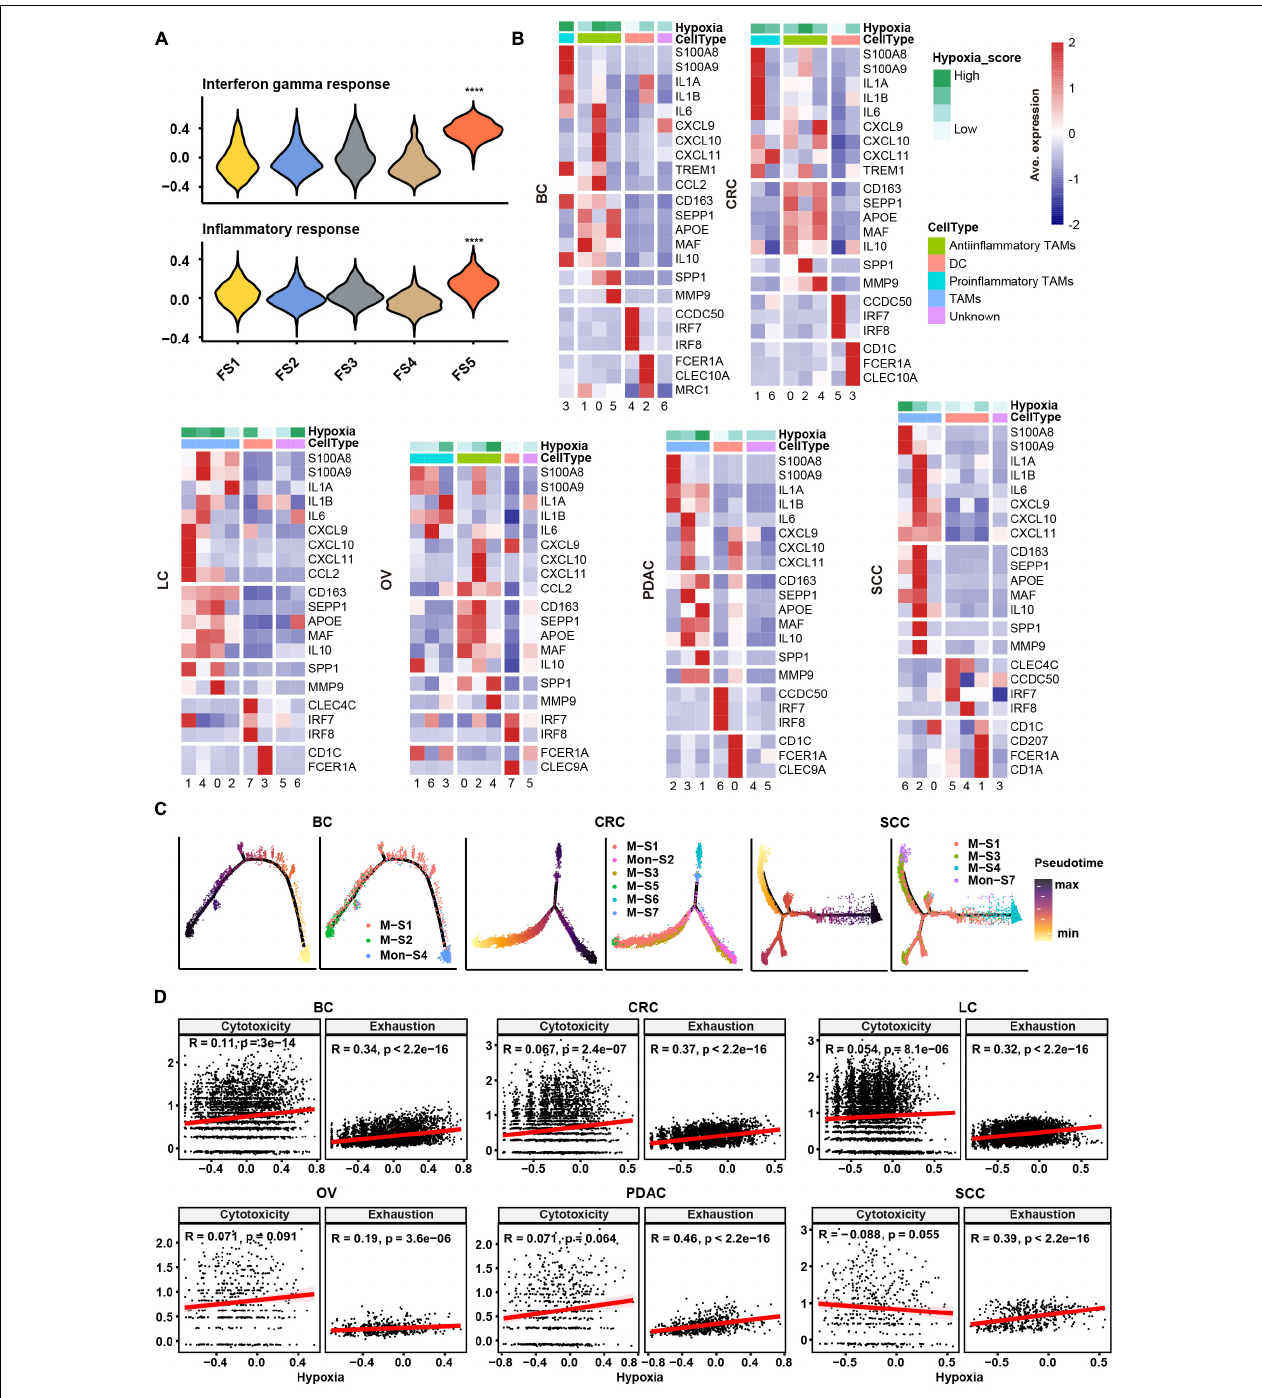
FIGURE 2 | Subtype classification and characteristics of non-malignant cells across cancer types. (A) Hallmark gene set scores for interferon gamma response (top) and inflammatory response (bottom), computed for all fibroblast clusters in BC. FS1, FS2, FS3, FS4, and FS5 are subclusters 0, 1, 2, 3, and 4 in stromal cells, see Materials and Methods and Supplementary Figure 2A . **** p ≤ 0.0001, two-sided Wilcoxon rank sum test. (B) Heatmap of Z -score-normalized log 2 (count+ 1) expression of canonical marker genes for myeloid cells. The color of the square on the top map indicates the average hypoxia score for each myeloid cell cluster (low to high, light green to green). (C) The branched trajectory of myeloid cell state transition in cancer (BC), colorectal cancer (CRC), and squamous skin cancer (SCC) inferred by Monocle 2. Each dot corresponds to one single cell, colored according to its cluster label. Subclusters 0, 1, 2, 3, and 4 of macrophages/monocytes were labeled M-S1/Mon-S1, M-S2/Mon-S2, M-S3/Mon-S3, M-S4/Mon-S4, and M-S5/Mon-S5 in each cancer type, see Materials and Methods . (D) Correlation scatter plot between gene set variation analysis (GSVA) scores of hypoxia, cytotoxicity, or exhaustion.